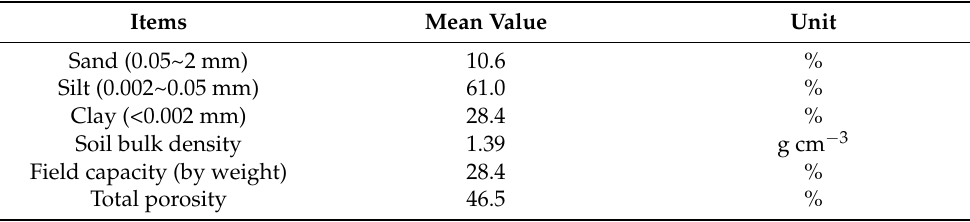
Table 1. Soil physical properties of the 0–30 cm profile before